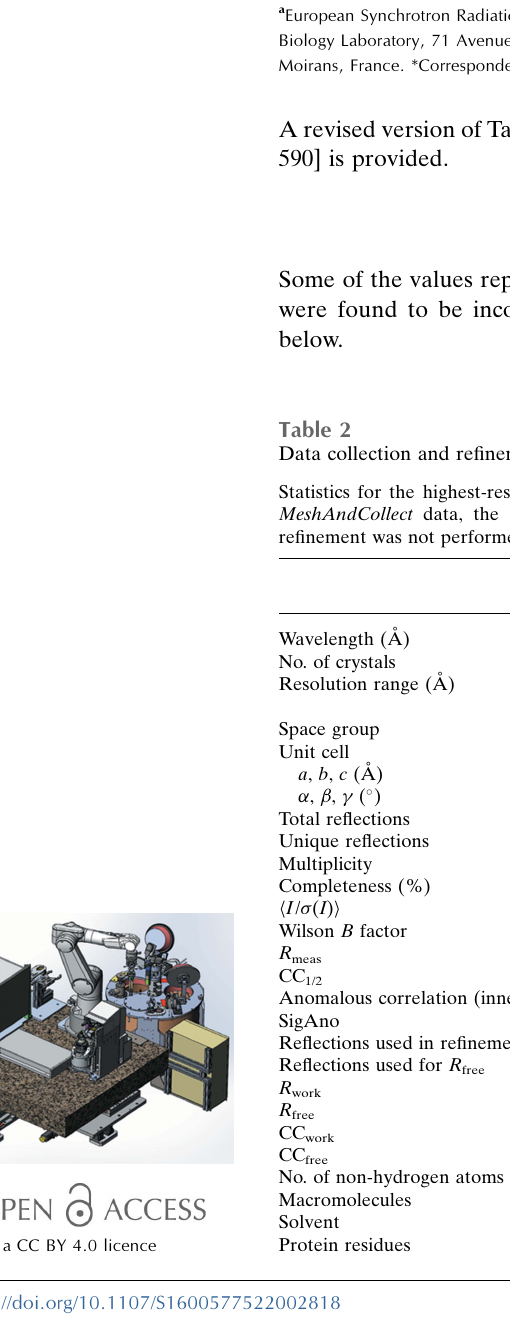
A revised version of Table 2 of Nanao et al. [ J. Synchrotron Rad. (2022). 29 , 581– 590] is provided.